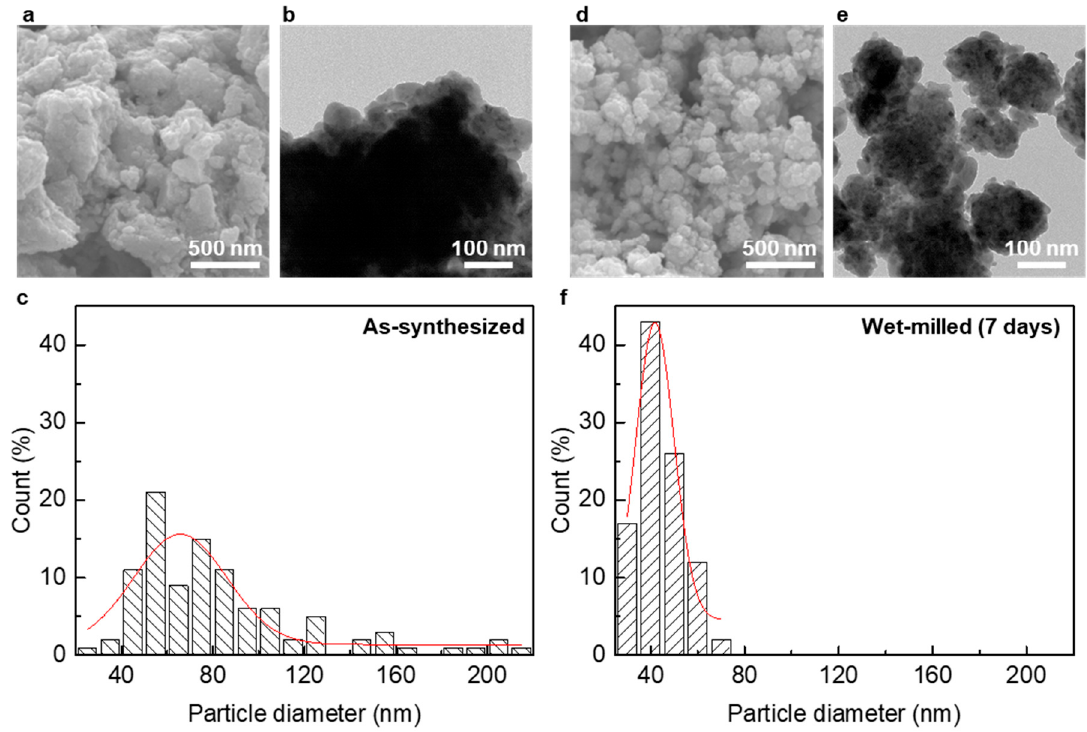
Figure 6. ( a , d ) SEM, ( b , e ) TEM, and ( c , f ) plots of size distribution of the as-synthesized BST NPs and post-wet-milled BST NPs, respectively.